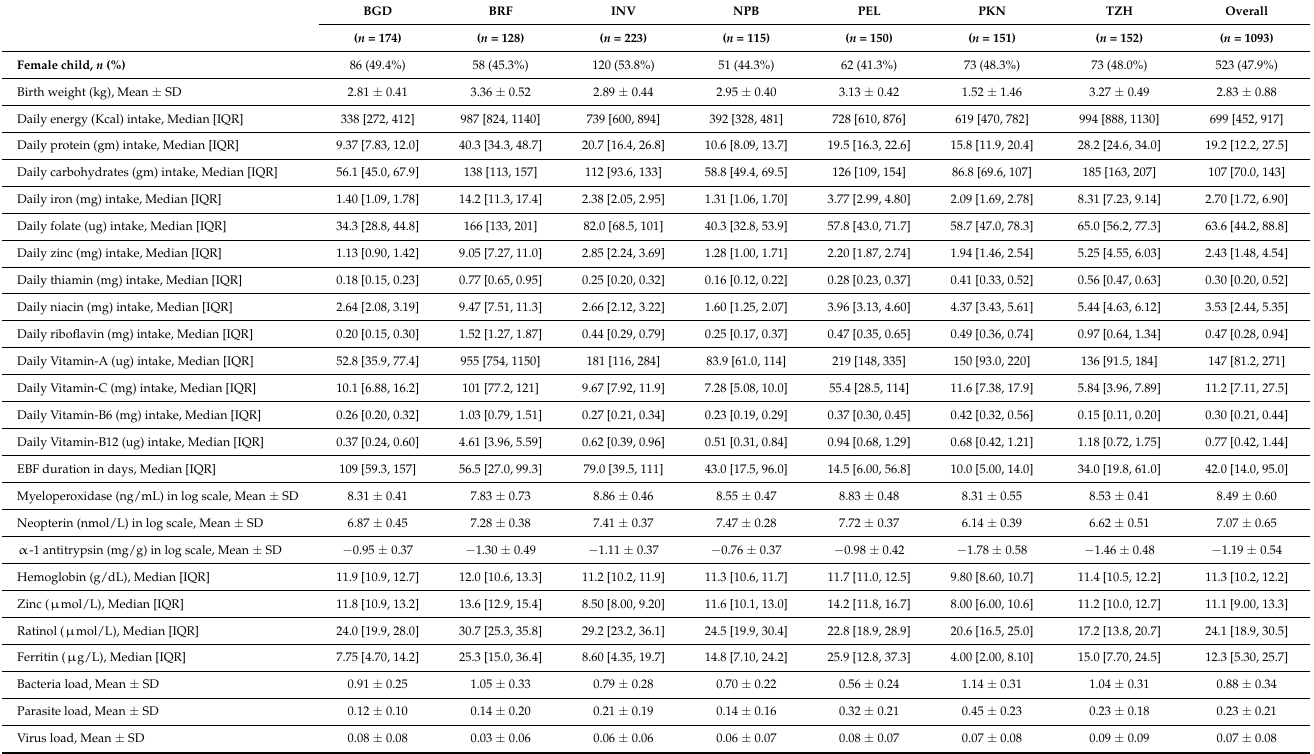
Table 2. Descriptive characteristics of the study participants, overall and by MAL-ED study